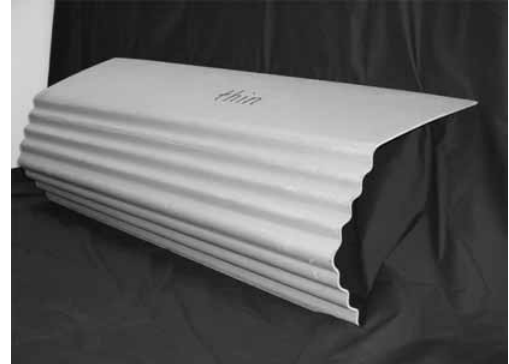
Fig. 14. Thin shield.